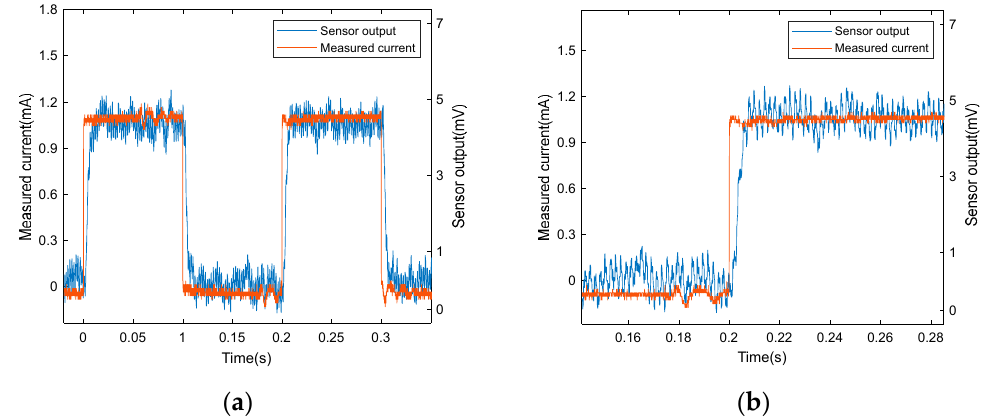
Figure 13. Output waveform at 1 mA DC square wave: ( a ) output waveform, and ( b ) details of the output waveform.